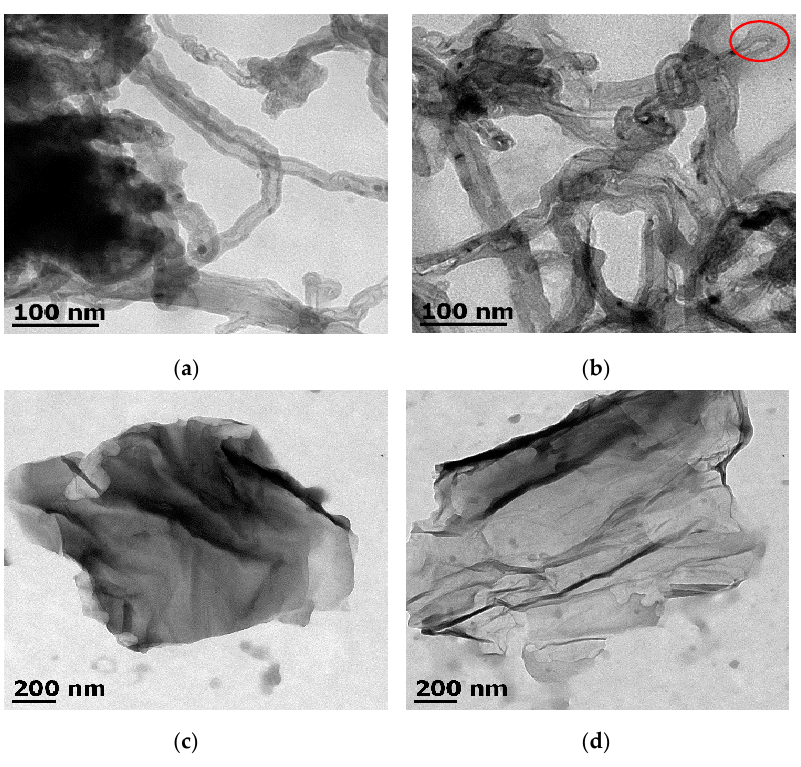
Figure 3. TEM micrographs of: ( a ) pristine MWCNT; ( b ) O-MWCNT; ( c ) GO; and ( d ) RGO.